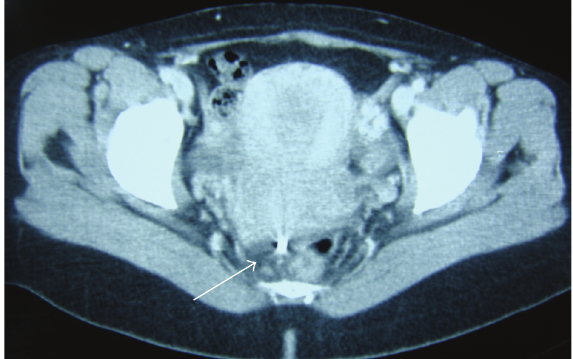
Figure 1: IUD is displayed in the rectum (arrow) after perforating the uterus located in